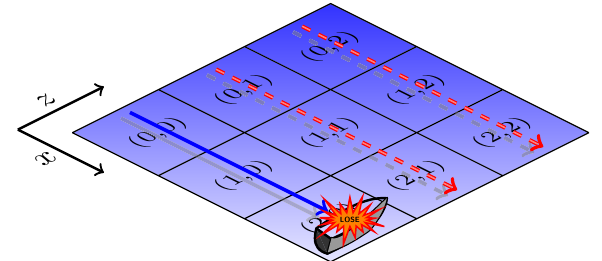
FIG. 1. The Torpedo Game is a pacificist alternative to Battle- ship where the aim is to avoid sinking Alice’s ship, depicted here in dimension